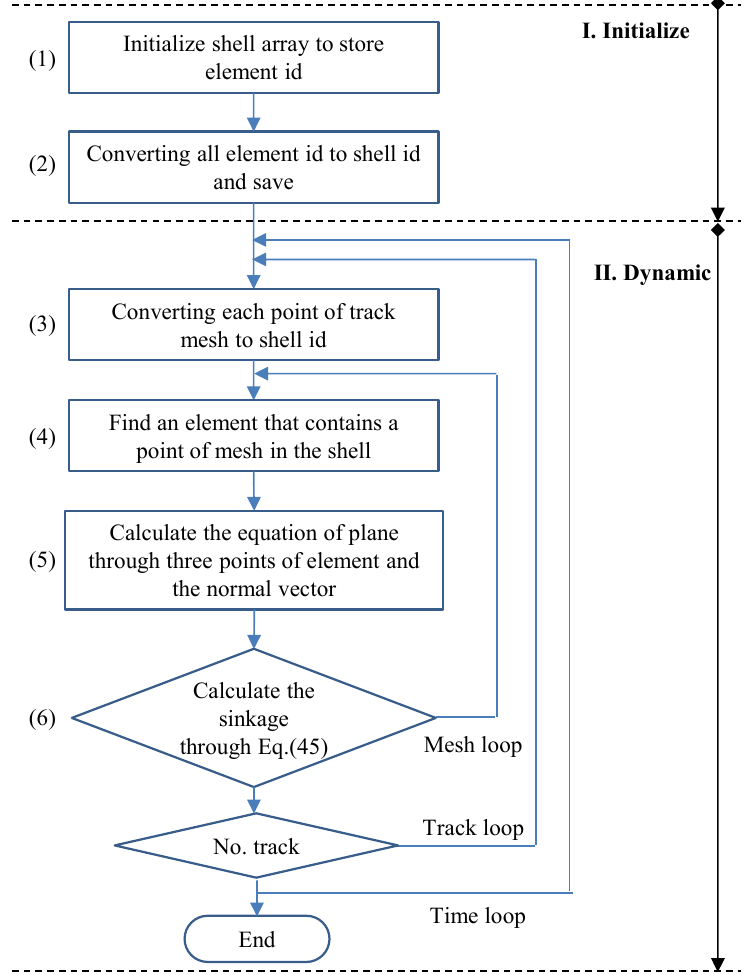
Figure 19. Algorithm for efficient contact calculation between 3D ground and mining robot.